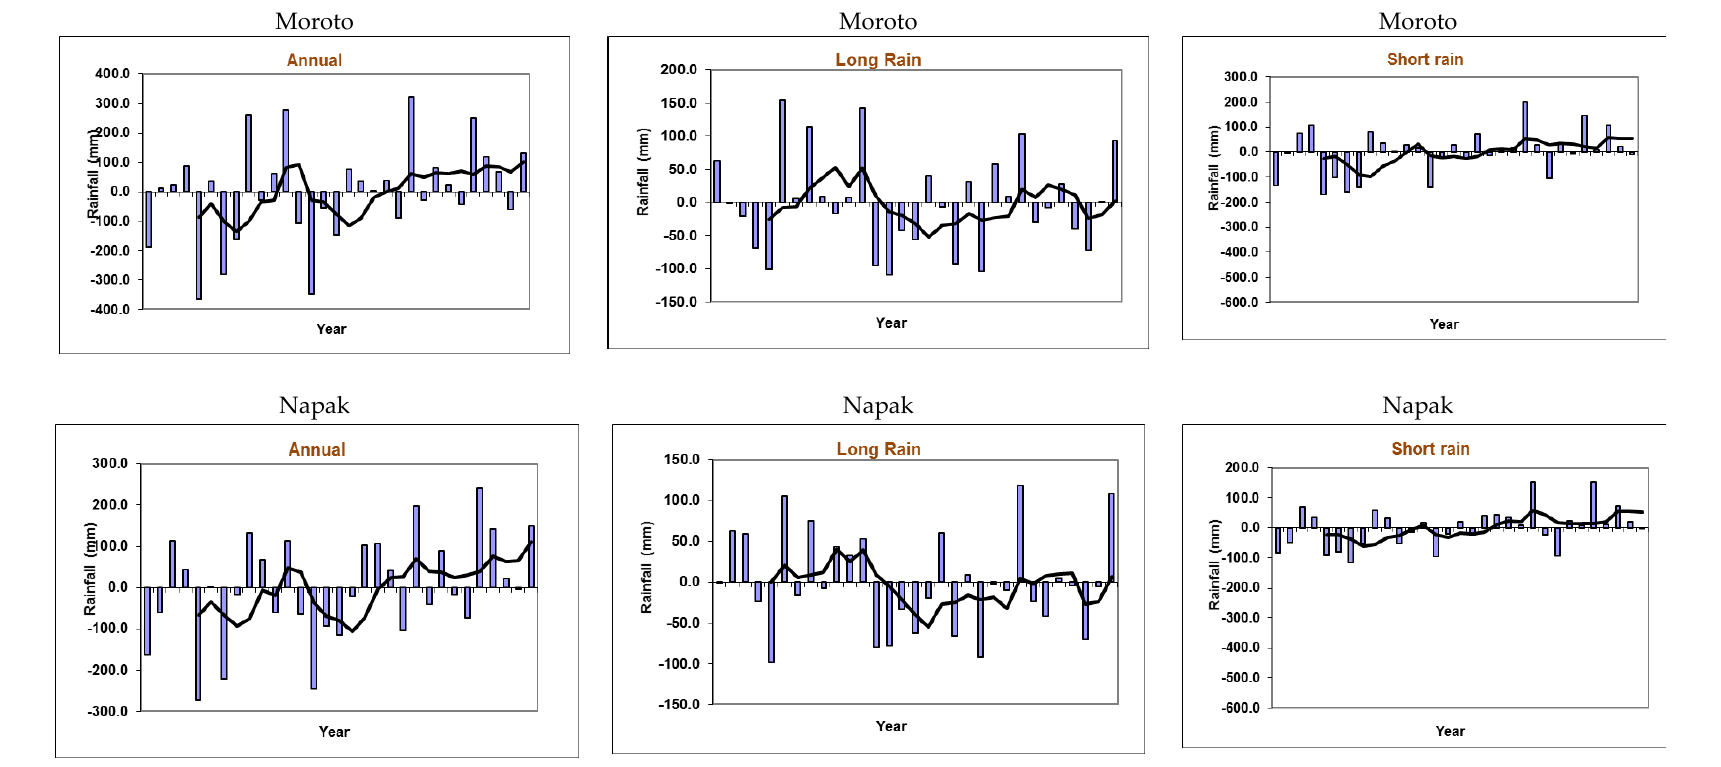
Figure A1. Historical rainfall.